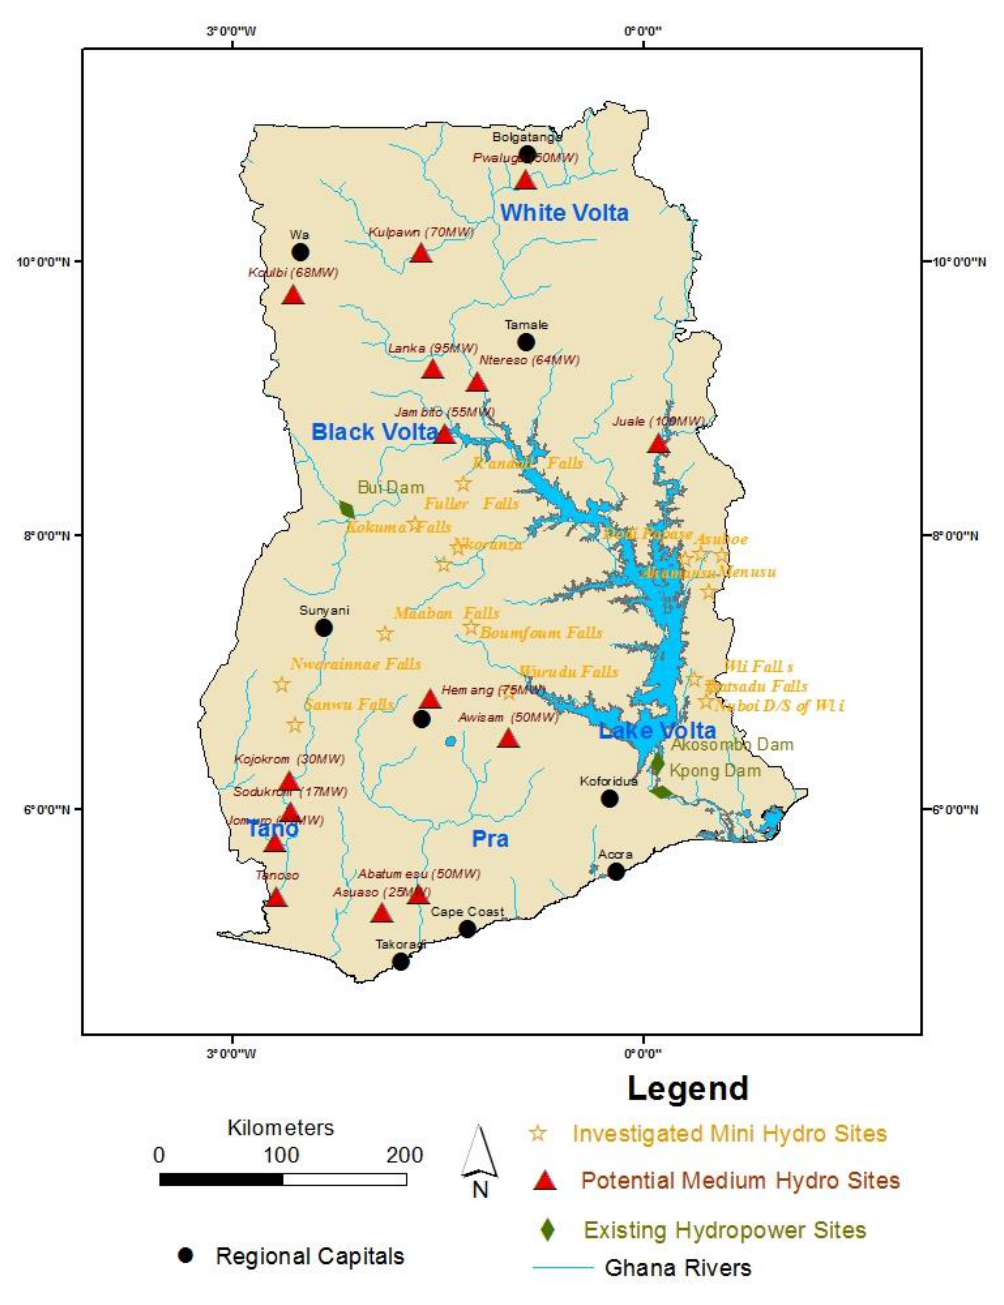
Figure 11. Map of Ghana showing potential mini and medium hydropower sites along with existing hydropower sites.